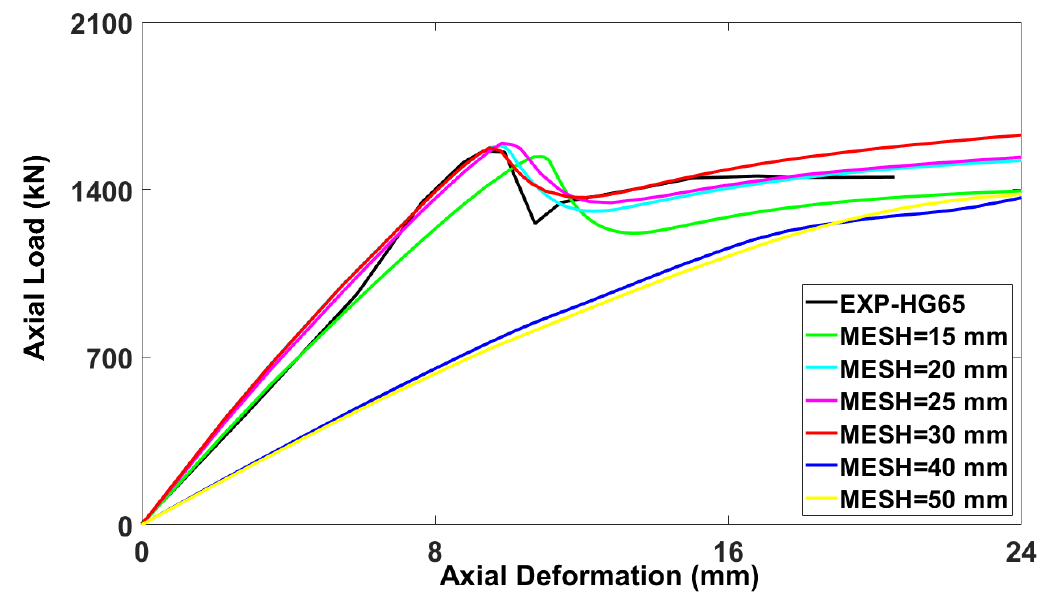
Figure 10. Calibration of control specimen (HG-65) for mesh